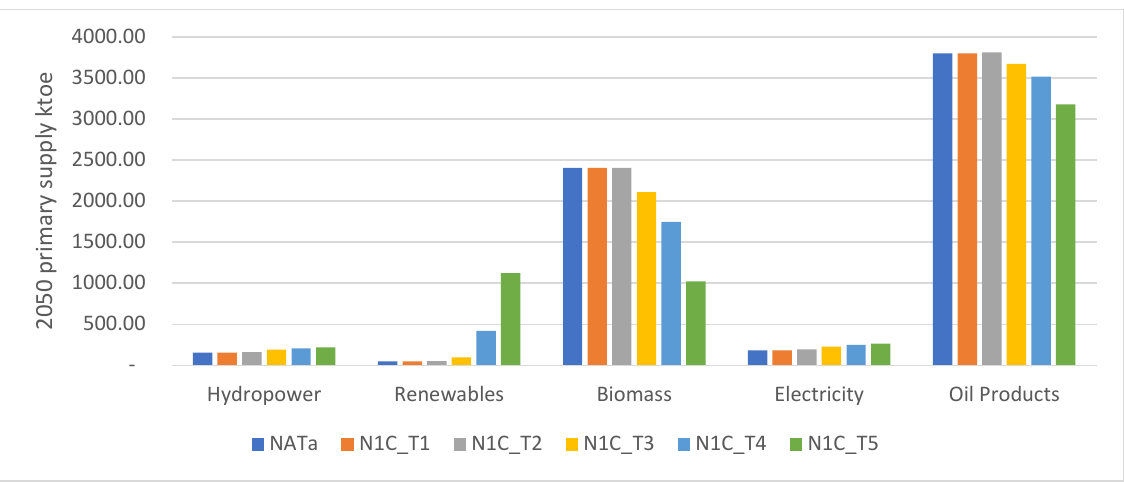
Figure 7. Energy supply by 2050 for scenarios based on NATb. While the results obtained with LEAP do not represent a timeline of events to reach rural electrification by 2050, it presents the picture of a possible future. For the QGIS results, three timestamps were used: 2030, 2040, and 2050. These timestamps can be seen in Error! Reference source not found. for 2030, Error! Reference source not found. for 2040, and Error! Reference source not found. for 2050. As the meth- odology describes, each colored spot on the map is a hexagonal geographical unit of 5 km of internal diameter. Each colored unit represents which tier of electrification is both via- ble and affordable for the geographical unit.